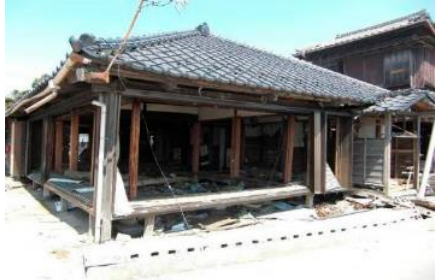
Figure 26. Wooden house, inundation depth 2 m, wall destruction, Kitaibaraki City.